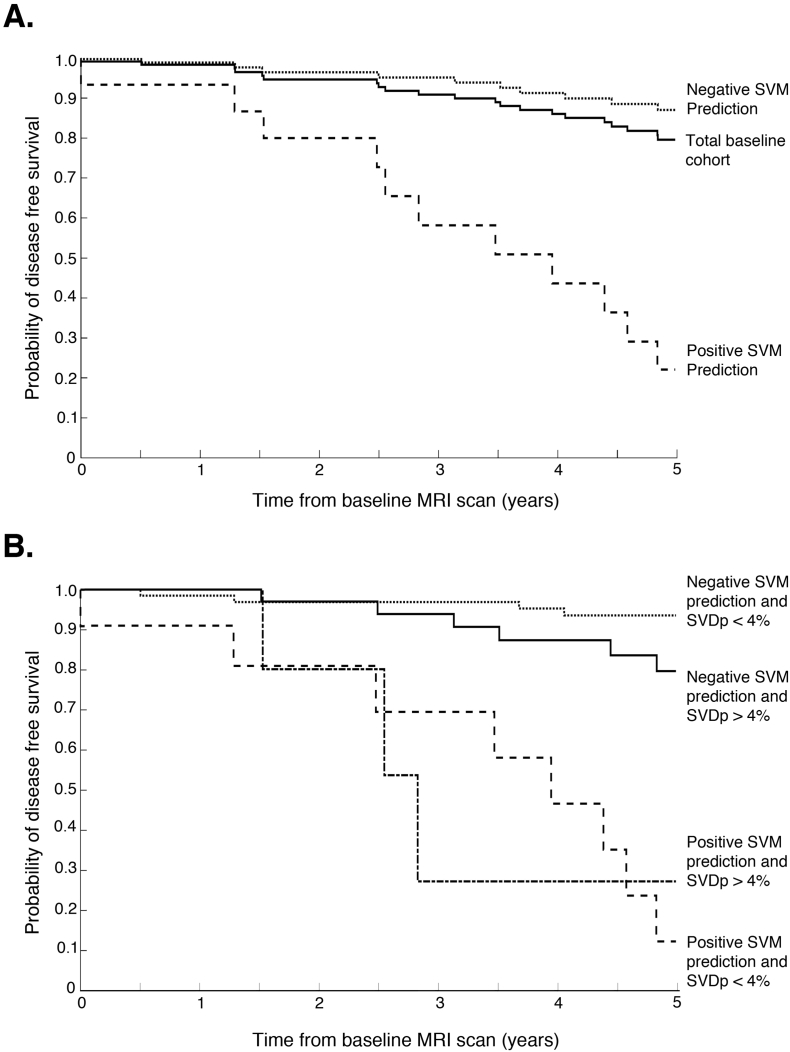
Kaplan-Meier survival plots for dementia onset. A. Total group risk plotted with positive and negative SVM predictions (log-rank P = 0.002). B. SVM predictions stratified according to vascular burden (Low - SVDp <4%; High – SVDp >4%; log-rank P = .005 between SVM prediction groups but not significant within groups).